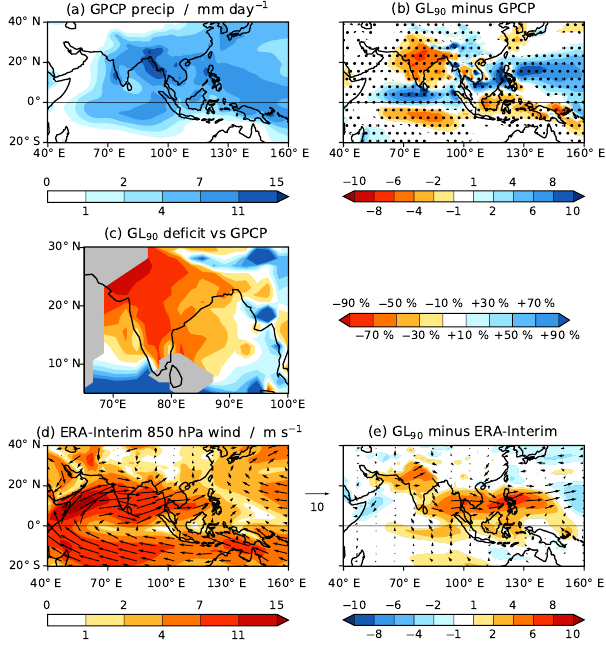
Figure 2. (a) JJAS mean precipitation from GPCP. (b) Bias in JJAS mean precipitation in GL 90 . Stippling indicates 99% statis- tical significance according to a two-tailed t test. (c) Percentage ex- cess (blue) and deficit (red) JJAS mean precipitation in GL 90 rel- ative to GPCP. Regions in which the GPCP climatology is below 3mmday − 1 are greyed out. (d) JJAS mean 850hPa wind (vectors) and wind speed (shading) from ERA-Interim. (e) Bias in JJAS mean 850hPa wind (vectors; shown only if statistically significant at the 99% level according to a two-tailed t test) and wind speed (shad- ing; bias of the wind speed, not the magnitude of the bias vectors) in GL 90